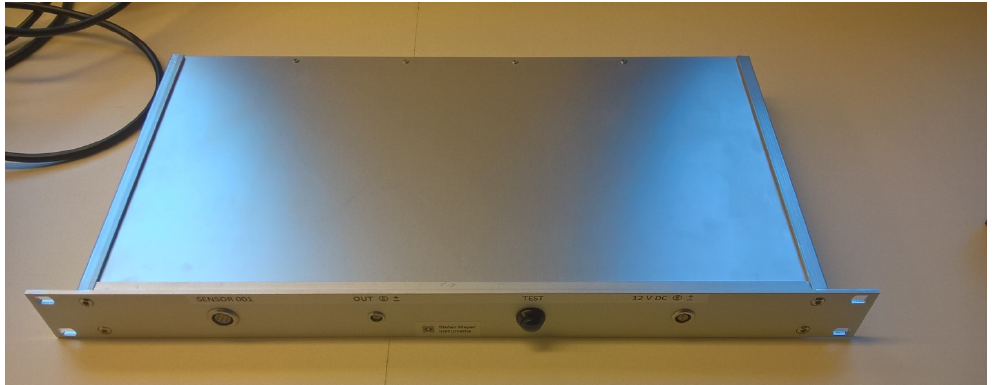
Figure 5. Picture of the assembled MITICA fluxgate sensing part.